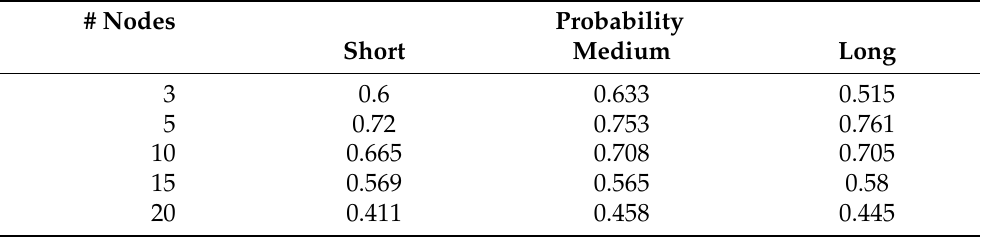
Table 3. Probability of quality downgrade events with variable number of nodes.